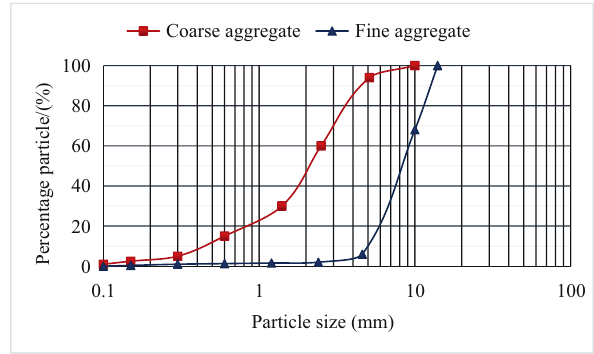
Figure 1: Particle size distribution of fi ne and coarse aggregate.